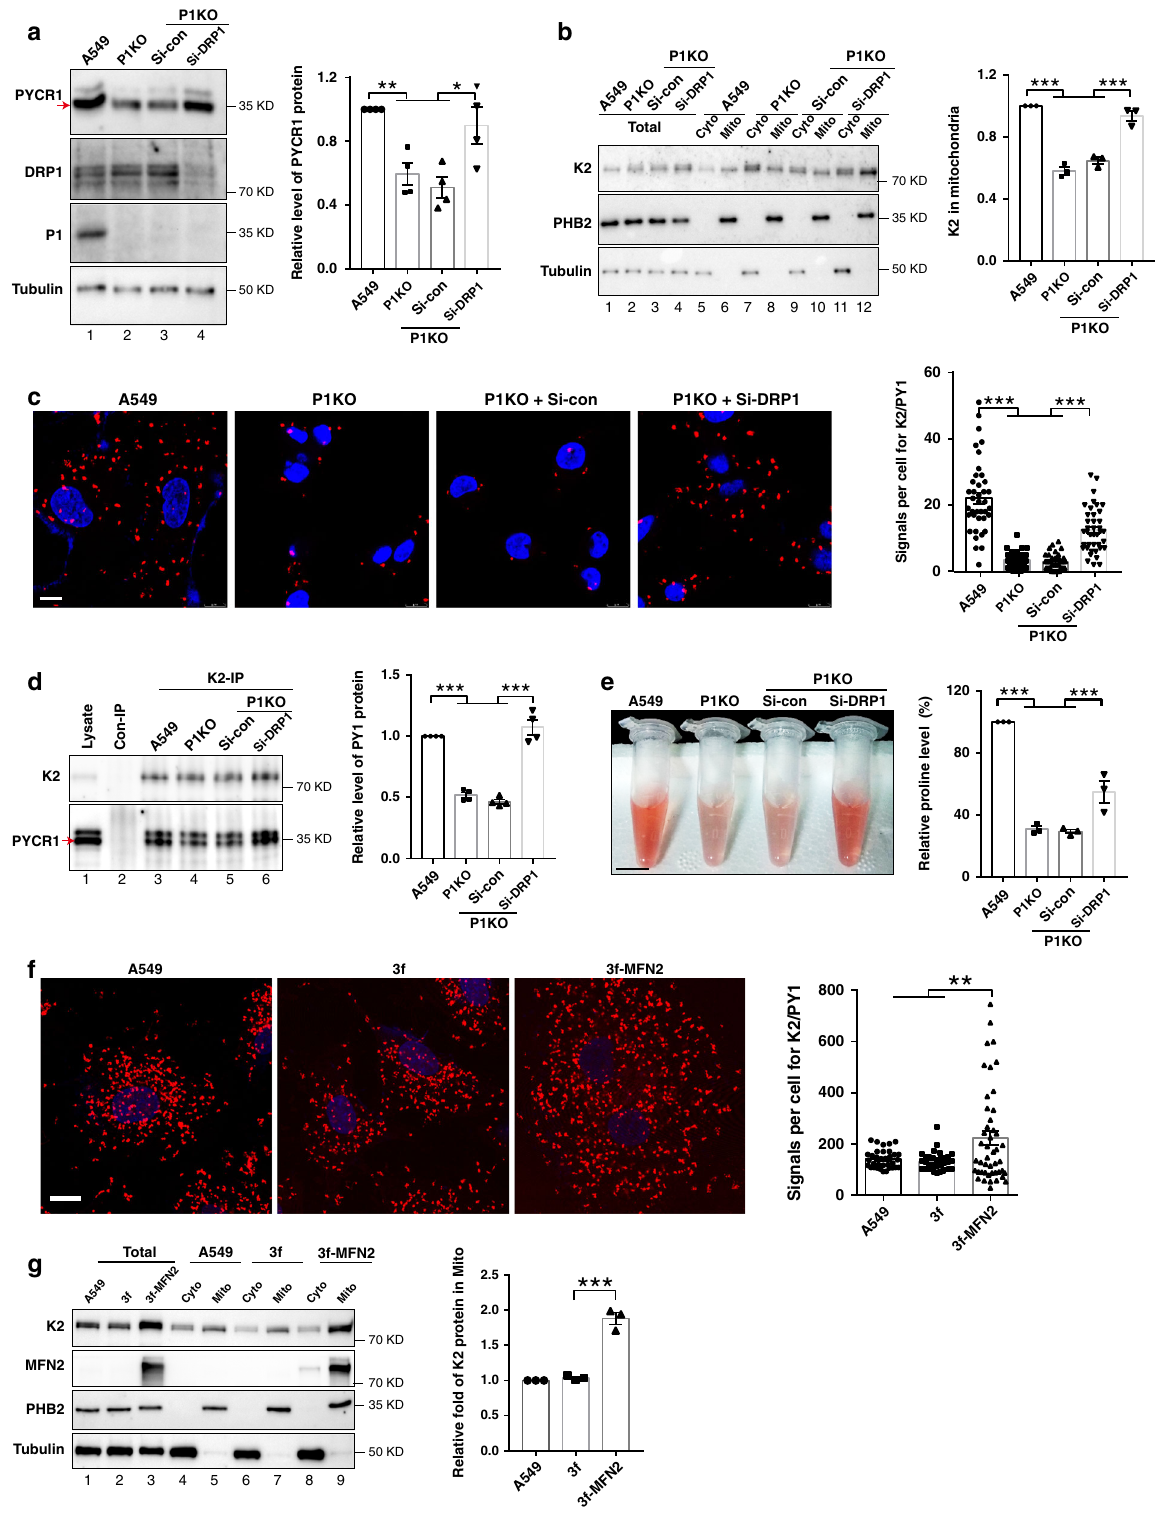
the PINCH-1, PYCR1, DRP1, or collagen1A1 staining within the tumor tissues. The highest MOD of the PINCH-1, PYCR1, DRP1, or collagen1A1 staining was normalized to 1. For quanti fi cation of Ki67 or cleaved caspase-3 staining, the numbers of Ki67 or cleaved caspase-3 positive cells in each fi eld were manually counted. For each experimental group, six sections of lung tissues from 6 individual mice were selected and more than 5 fi elds for each section were